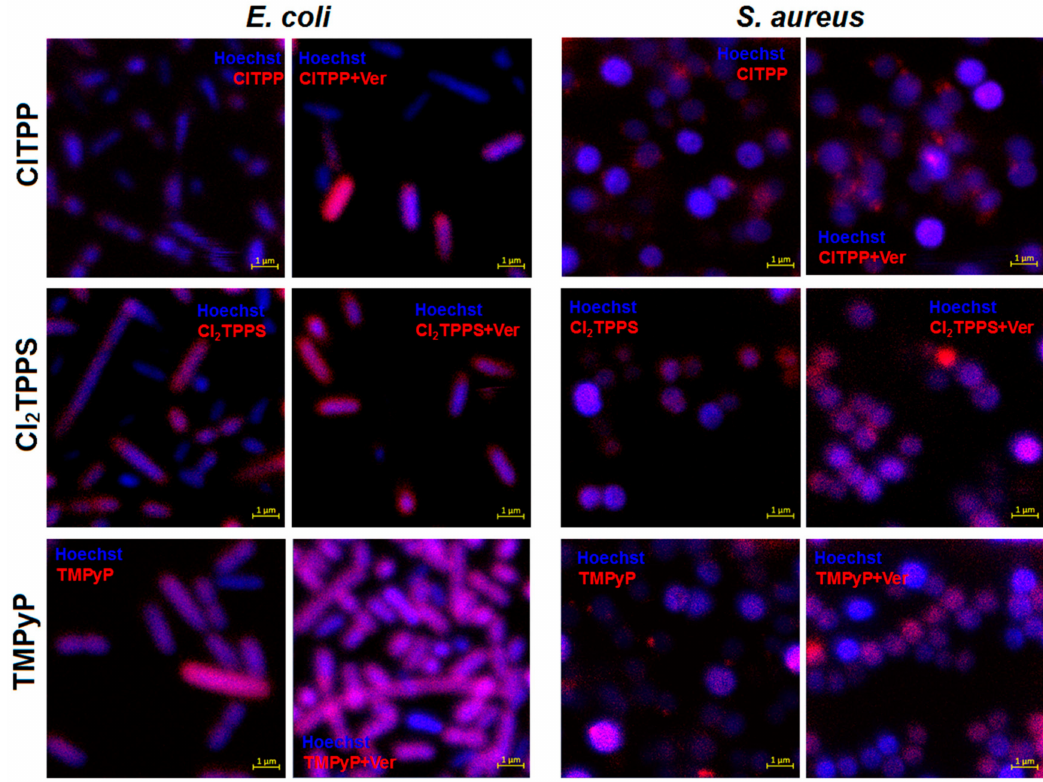
Figure 12. Laser scanning confocal microscopy imaging of porphyrin accumulation with di ff erent overall charges (ClTPP, Cl 2 TPPS, and TMPyP) and with the addition of verapamil (Ver) in E. coli and S. aureus .